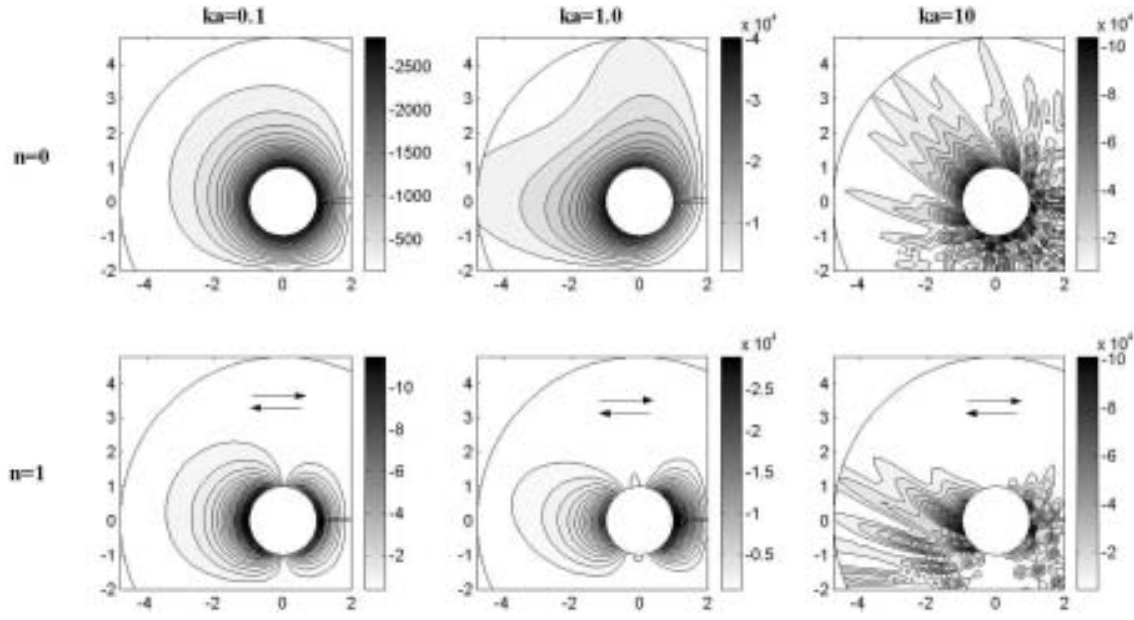
Fig. 8. Radiation intensity distribution in the vicinity of the spherical source located one radius away from the quarterspace boundary ( d 1 = d 2 = a ) at selected excitation